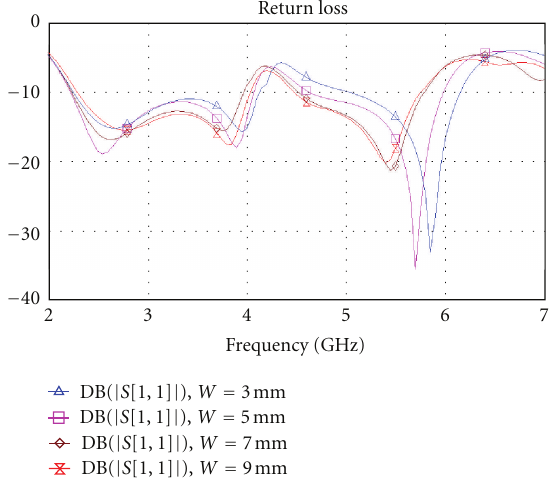
Figure 2: Simulation return loss of hybrid DR antenna with di ff erent DR height.